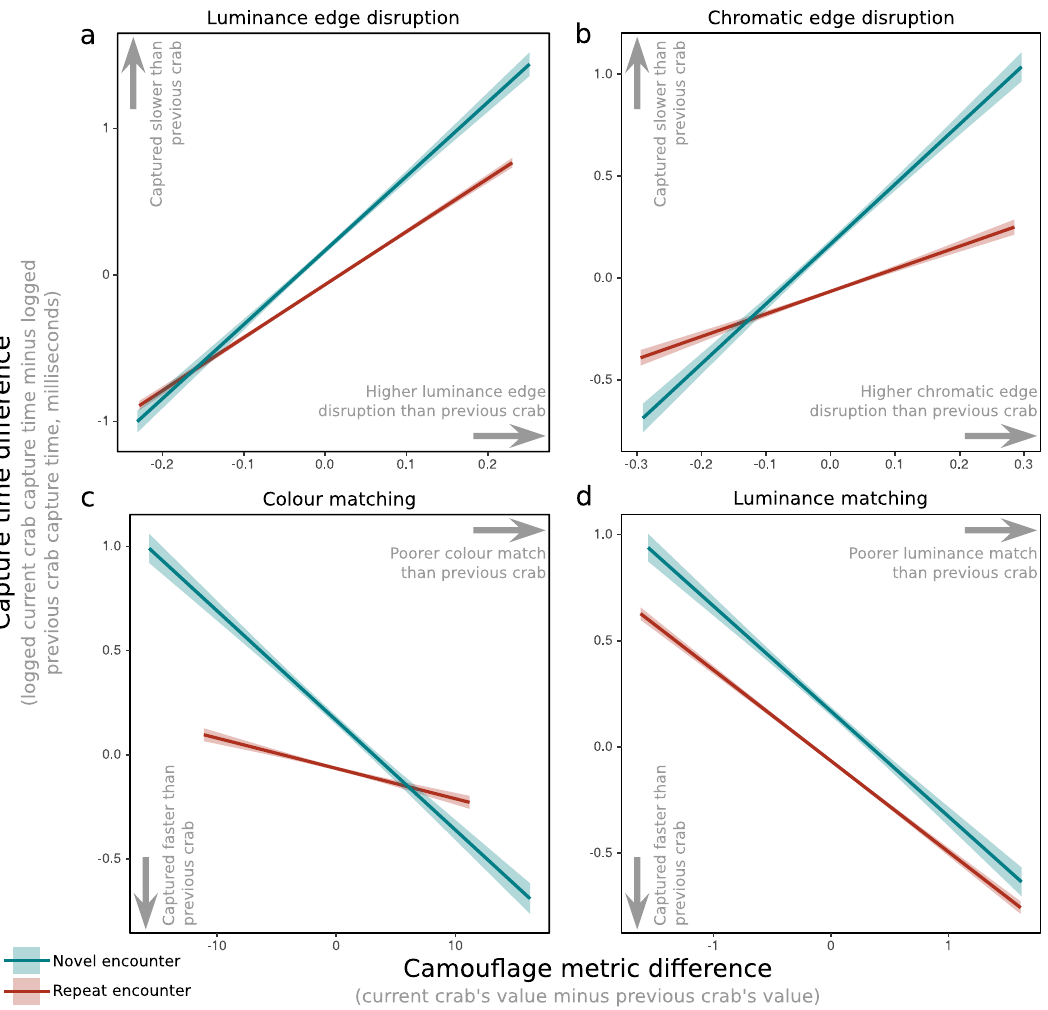
Fig. 4 Plots showing camou fl age difference versus capture time differences with each crab encounter. Regression lines have been fi tted to the raw data with standard error shown in shaded regions, based on 40,272 observations from 1751 participants. a and b (luminance edge disruption and chromatic edge disruption) show that crabs of a novel phenotype and high edge disruption take longer to be captured than crab phenotypes that have been encountered previously. c and d (colour matching and luminance matching) show that novel crabs with a better colour match to their surrounding than the previous crab take longer to be captured than crabs which have been encountered previously. This interaction is most pronounced for colour